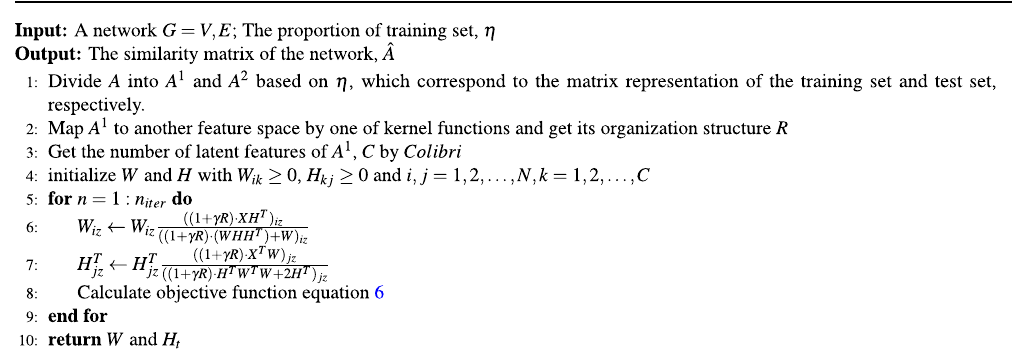
Algorithm 1. Algorithm for the NMF 3 framework based on the procedure of link